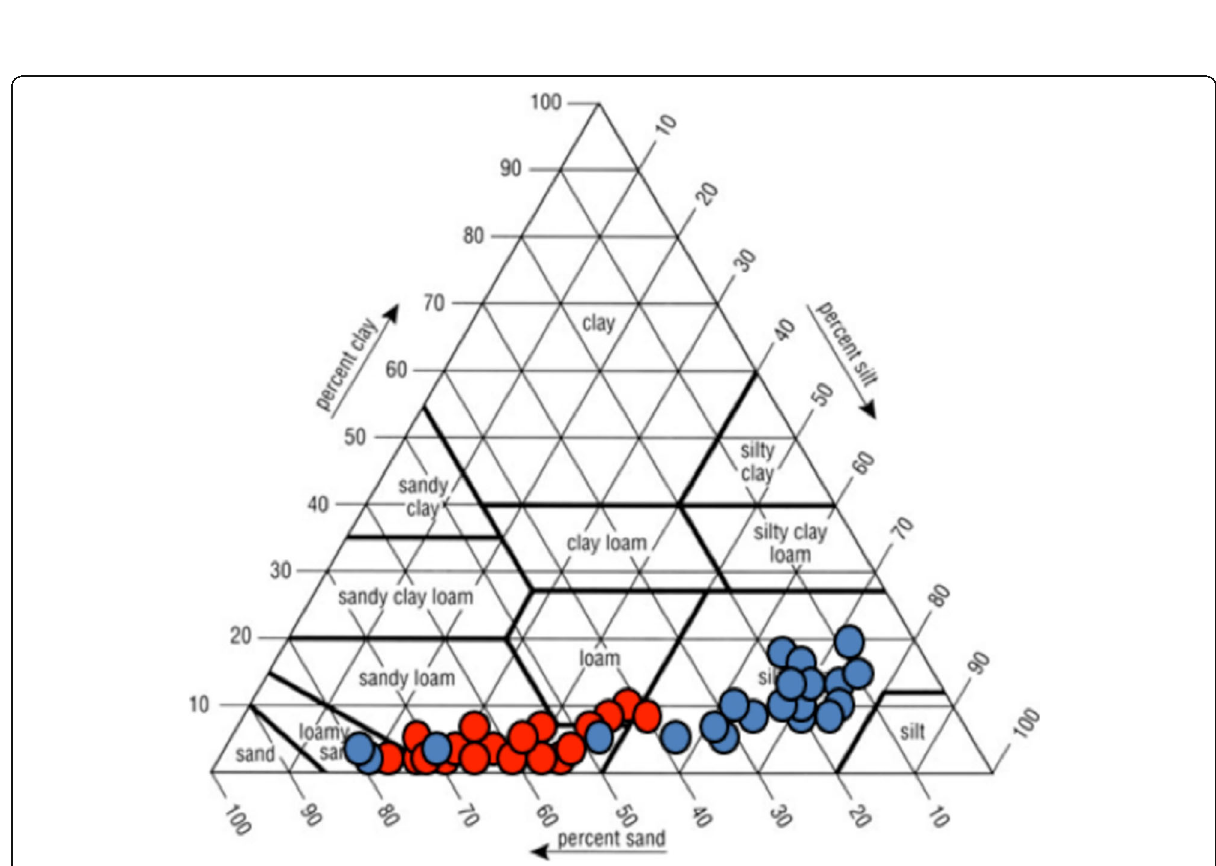
Fig. 3 Textural classification of sediment from KR1 (red dots) and KR2 (blue